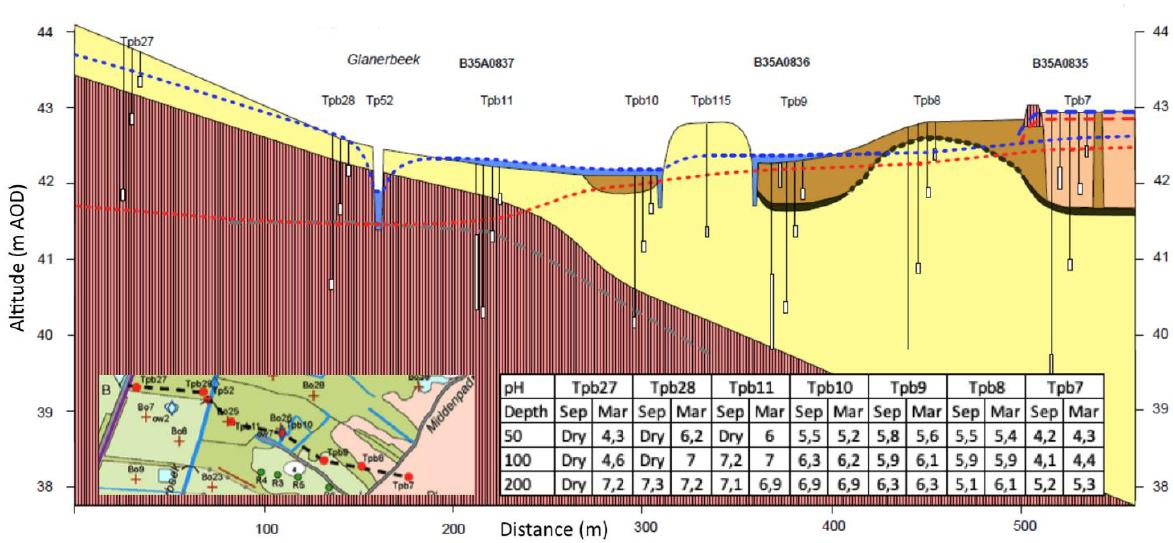
Figure 3. Geohydrological cross section near Transect 3 with pH values of groundwater, sampled in wells at different depths (in cm), after Van Mullekom et al . 2016). Locations, numbers and depths of the monitoring wells are indicated by symbols. For the legend, see Figure